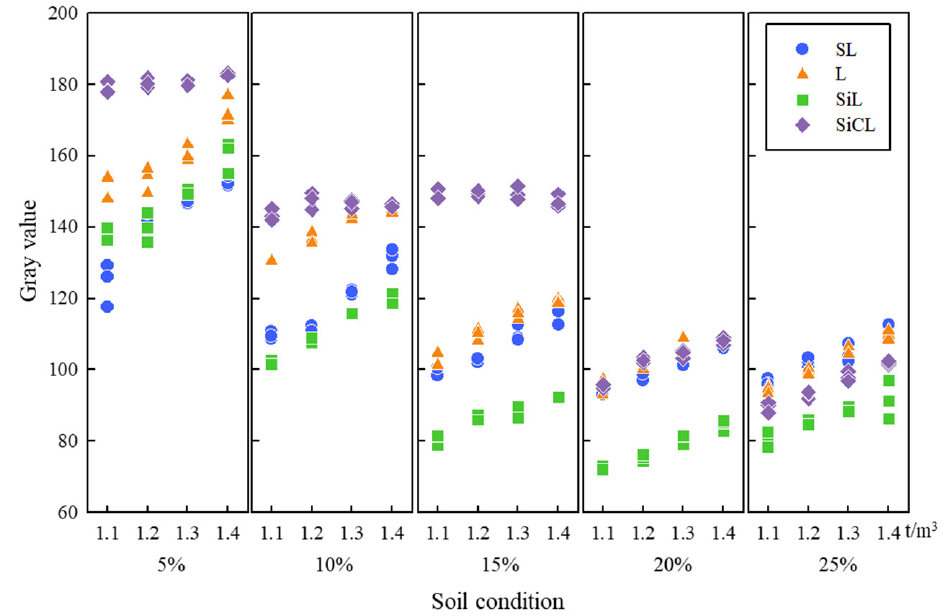
Figure 4. Gray value of original soil surface images according to soil texture, soil water content and soil dry density.